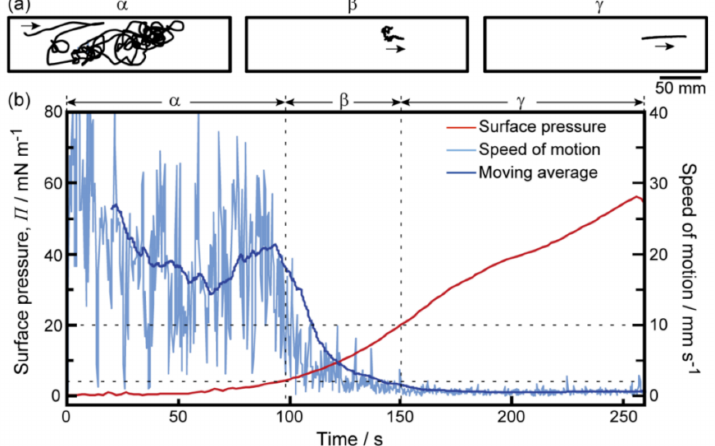
Figure 2. Global motion modes of a camphor disk with a decrease in the surface area of a MANA monolayer containing the camphor disk at 298 K. ( a ) The trajectory of a camphor disk during compression; ( b ) time variation in the surface pressure, Π (red line), and the 20 s moving average speed of the camphor disk (blue line) on the monolayer. The pale blue line indicates actual speed of the camphor disk. The reproducibility of these experiments was certified by five trials.